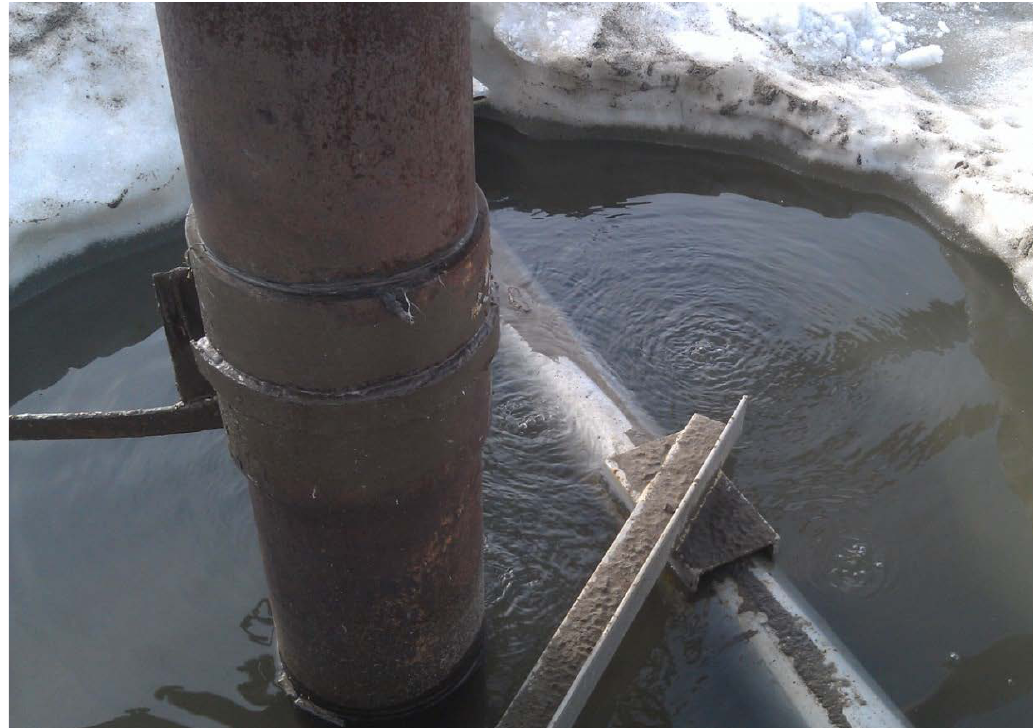
Figure 1. Gas releases in spring water around working gas well [7].